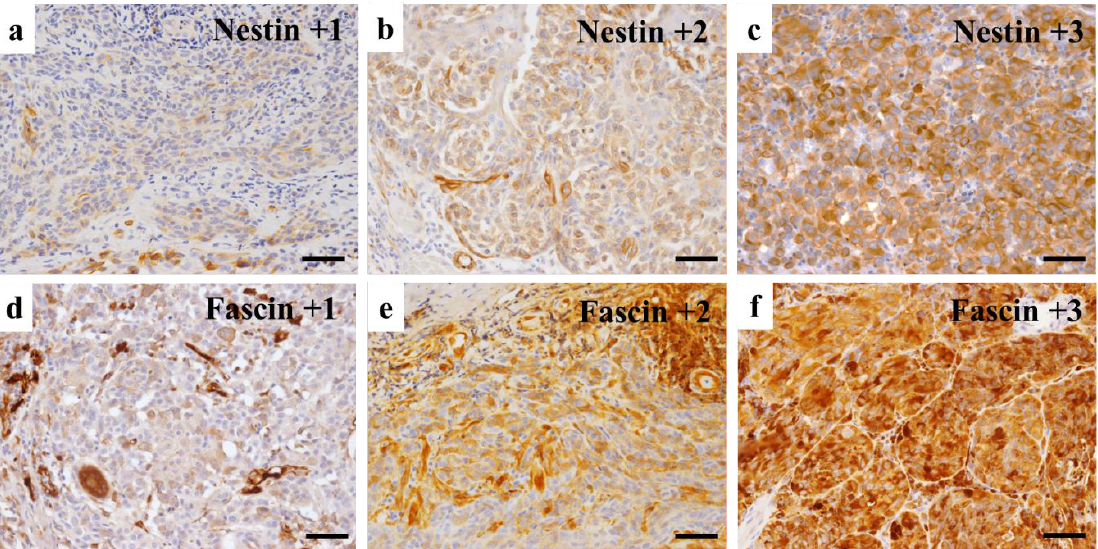
Figure 1. Evaluation of immunohistochemical expression intensity. The intensity of Nestin and Fascin staining was scored as no (0), weak (1), intermediate (2), and strong (3) to convert immunohistochemical expression strength to Allred scoring system. Representative images of the fields are shown for Nestin ( a – c ) and Fascin ( d – f ) intensity with +1, +2, and +3. (Scale bars: 50 μm) .